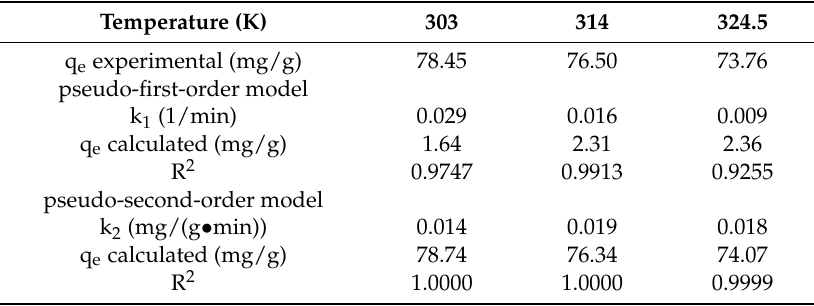
Figure 7. Pseudo-first-order ( a ) and pseudo-second order ( b ) kinetic models of adsorption of MB onto MPPL. Table 2. Kinetic parameters for MB dye adsorption onto MPPL.